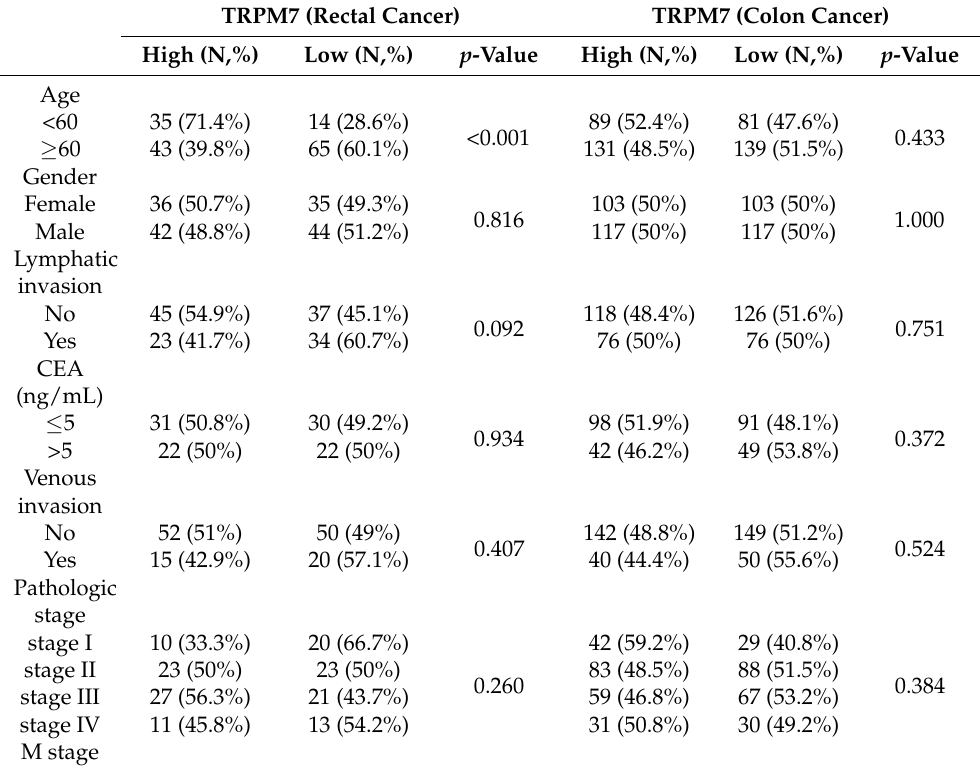
Table 1. Clinical characteristics of TRPM7 in colon and rectal